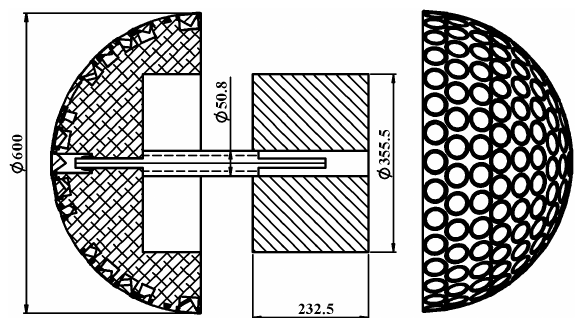
Figure 1. The LAGEOS satellites assembly as we obtained in Reference [38]. The main parts of the structure are shown: (i) two aluminum hemispheres containing the Corner Cube Retroreflectors (CCRs), (ii) the brass core, which increases the satellite mass, (iii) the copper-beryllium shaft that fastens the different parts of the satellites. Dimensions are in mm. This figure was redrawn to be similar to the historical one reported in Reference [36], well known in the literature of the older LAGEOS, but the quotes are different, as derived by our analysis